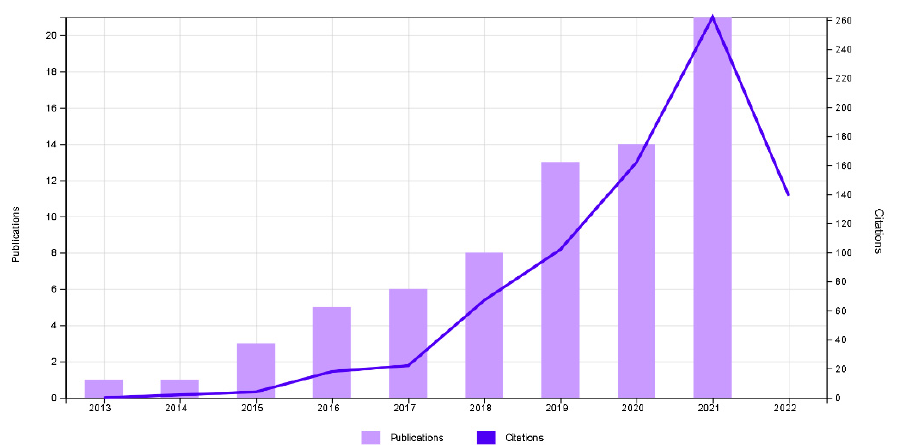
Figure 3. Years of publication (2013–2021) author adapted from Mendeley. 2022